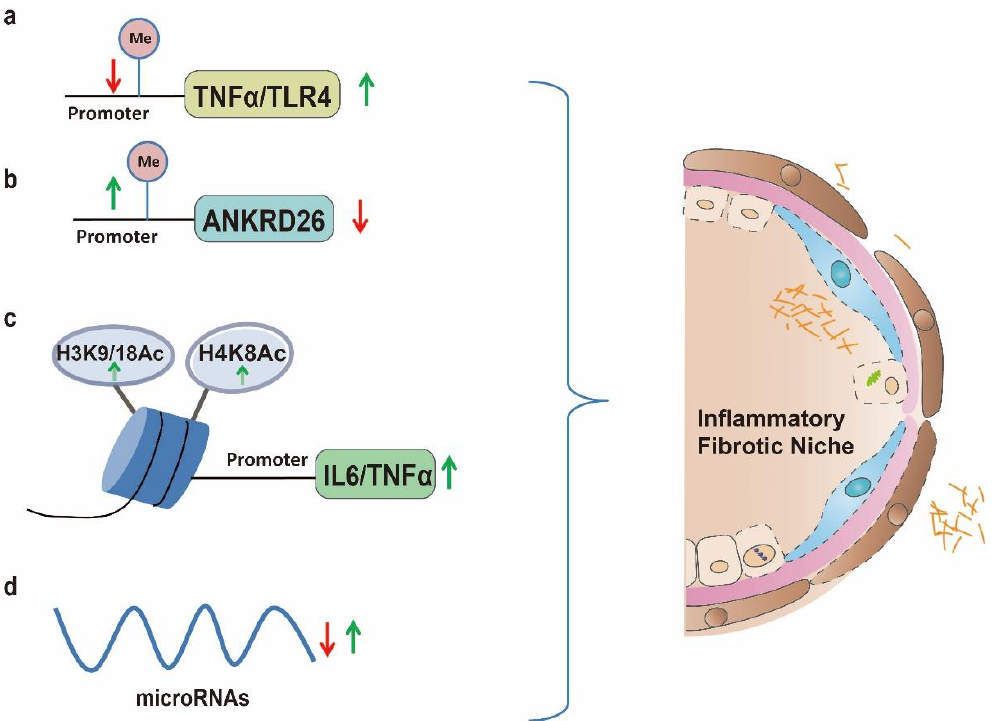
Figure 3. Epigenetically activation of inflammatory related genes play significant roles in fostering inflammation niche by HFD, thereby facilitating lung fibrosis progression. ( a ): HFD promotes TLR4 expression through demethylation of CpGs in the first exon whereby lead to low-grade pulmonary inflammation; ( b ): HFD led to hypermethylation of the Ankrd26 promoter region which in turn contribute to enhanced secretion of pro-inflammatory factors; ( c ): HFD increases histone acetylation at H3K9, H4K8, H3K18 which promoted pro-inflammatory cytokines in BALF; ( d ): Consumption of high-fat or high calorie diet (rich in fat) is shown to increase inflammatory response by altering miRNA expression such as increasing miR-155 and down regulating miR-30 could induce M1 macrophage polarization, thereby causing chronic